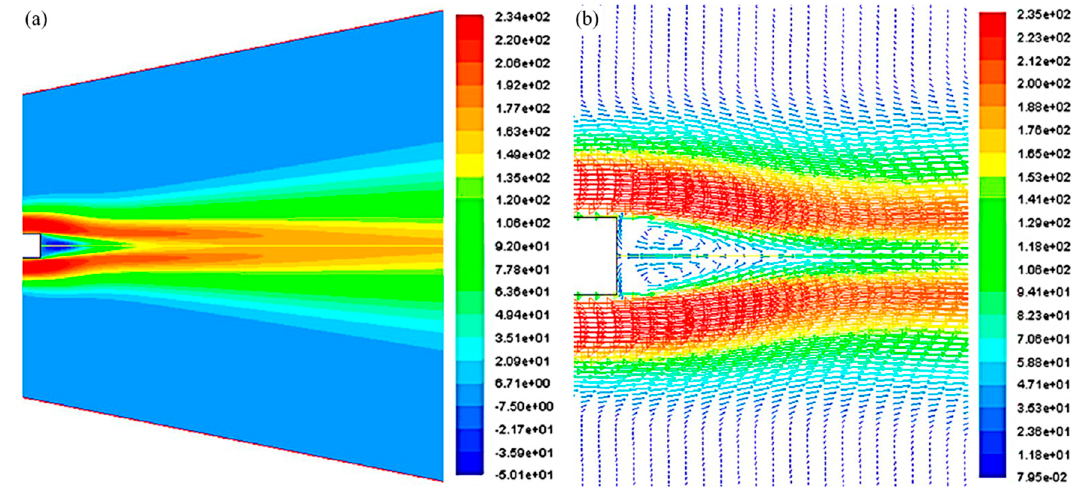
Figure 11. ( a ) Velocity contour. ( b ) Vector field in the vicinity of the nozzle end [100].